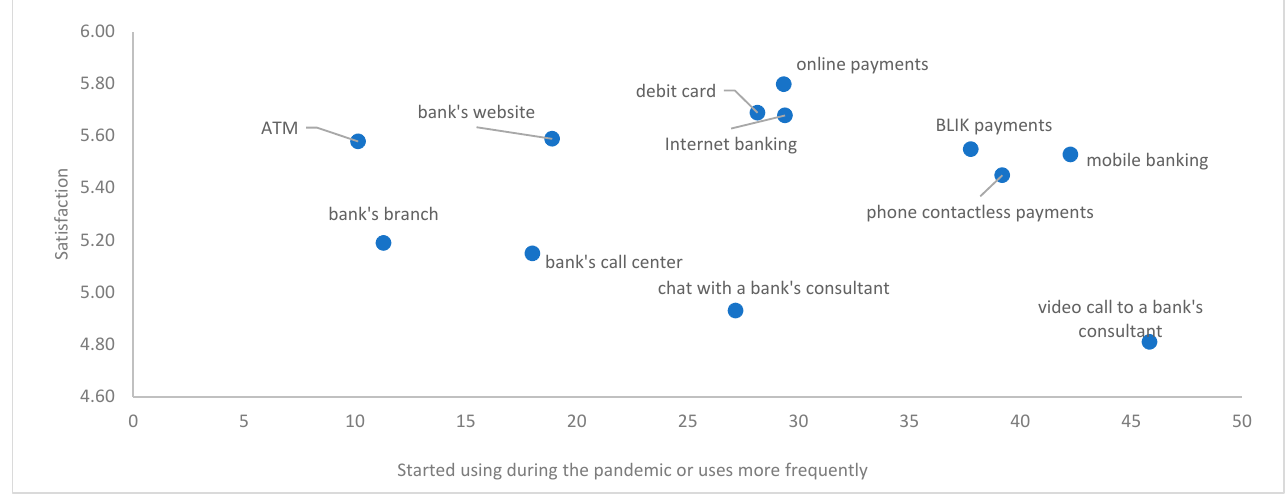
Figure 3. Satisfaction of contact initiation in new touchpoints, 1Q 2021. Source: own computation based on data from ZBP 2021.